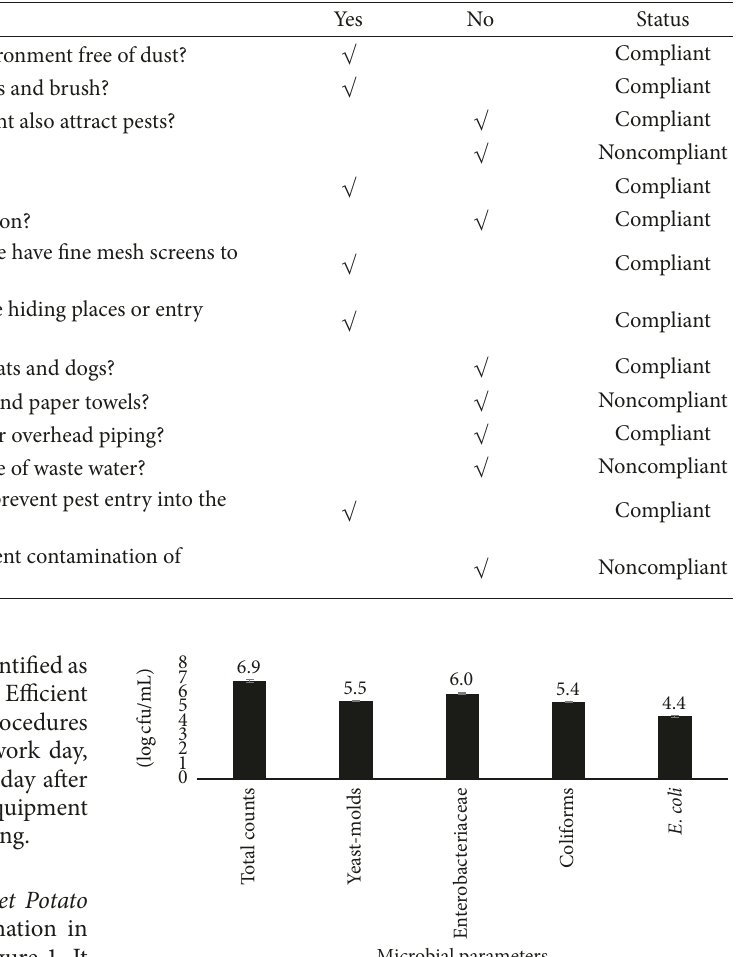
Table 3: Assessment of GMPs for buildings, grounds, and structures for OFSP puree processing.